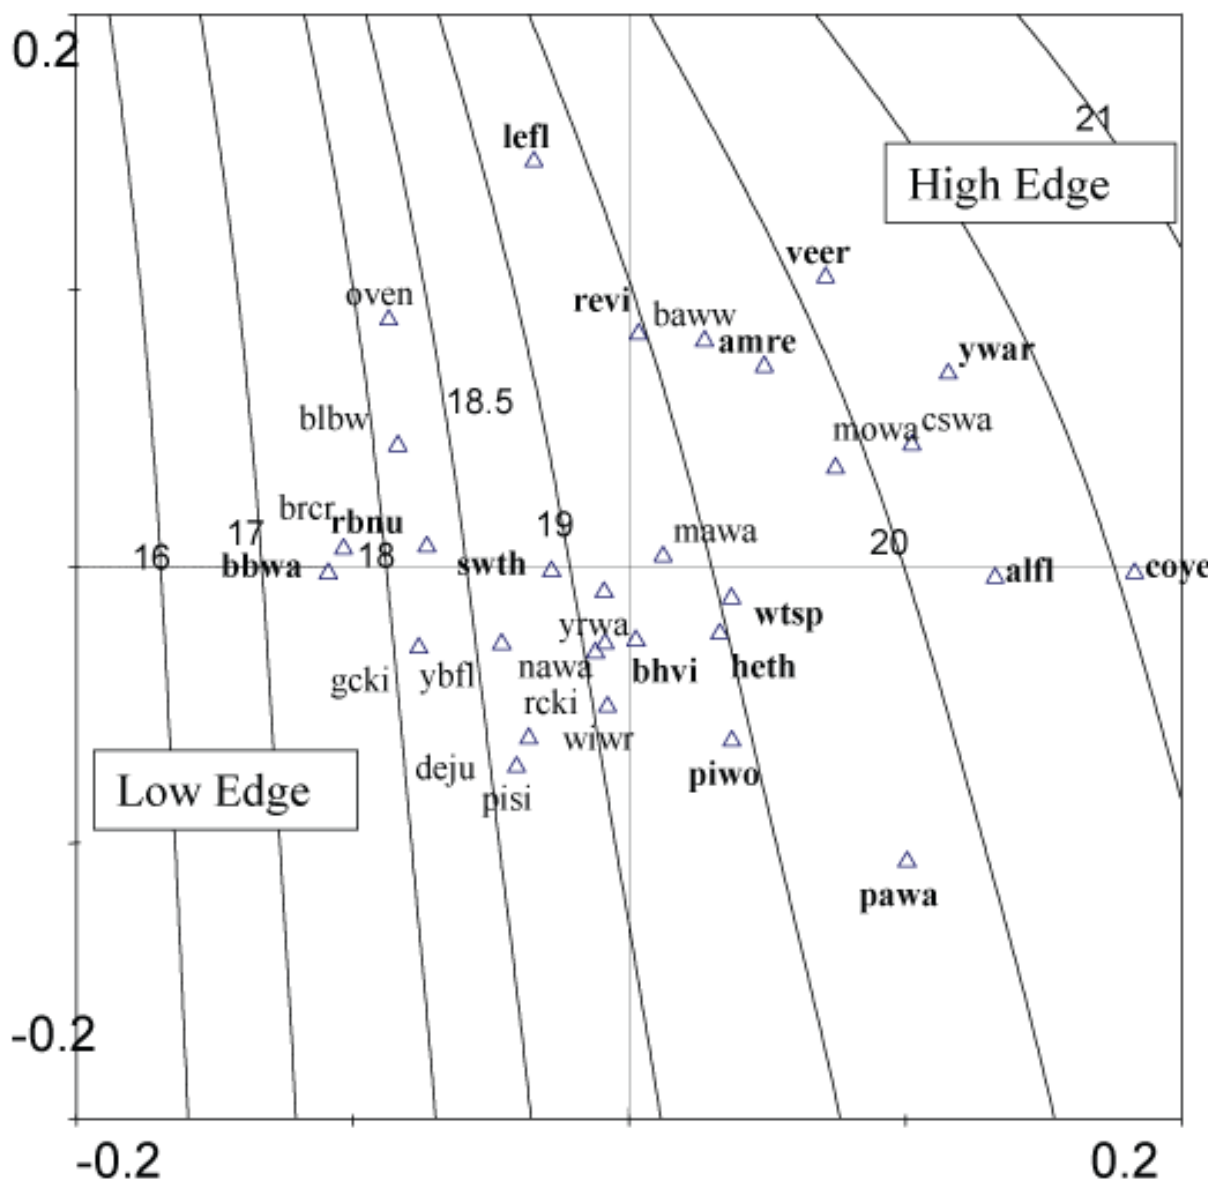
Fig. 3. Species ordination (CCA), with overlay of isopleths (GLM) for contrast weighted edge density (EDGE) in m/ha. Species with a significant effect (ANOVA p < 0.05) are highlighted in bold. Isopleths delineate species predicted to occur in areas of low to high density of